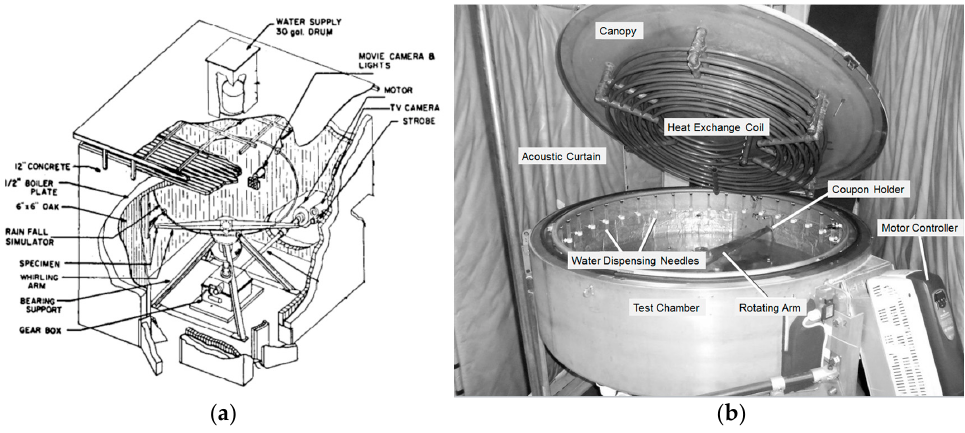
Figure 13. ( a ) Rain test facility at University of Dayton Research Institute, developed for